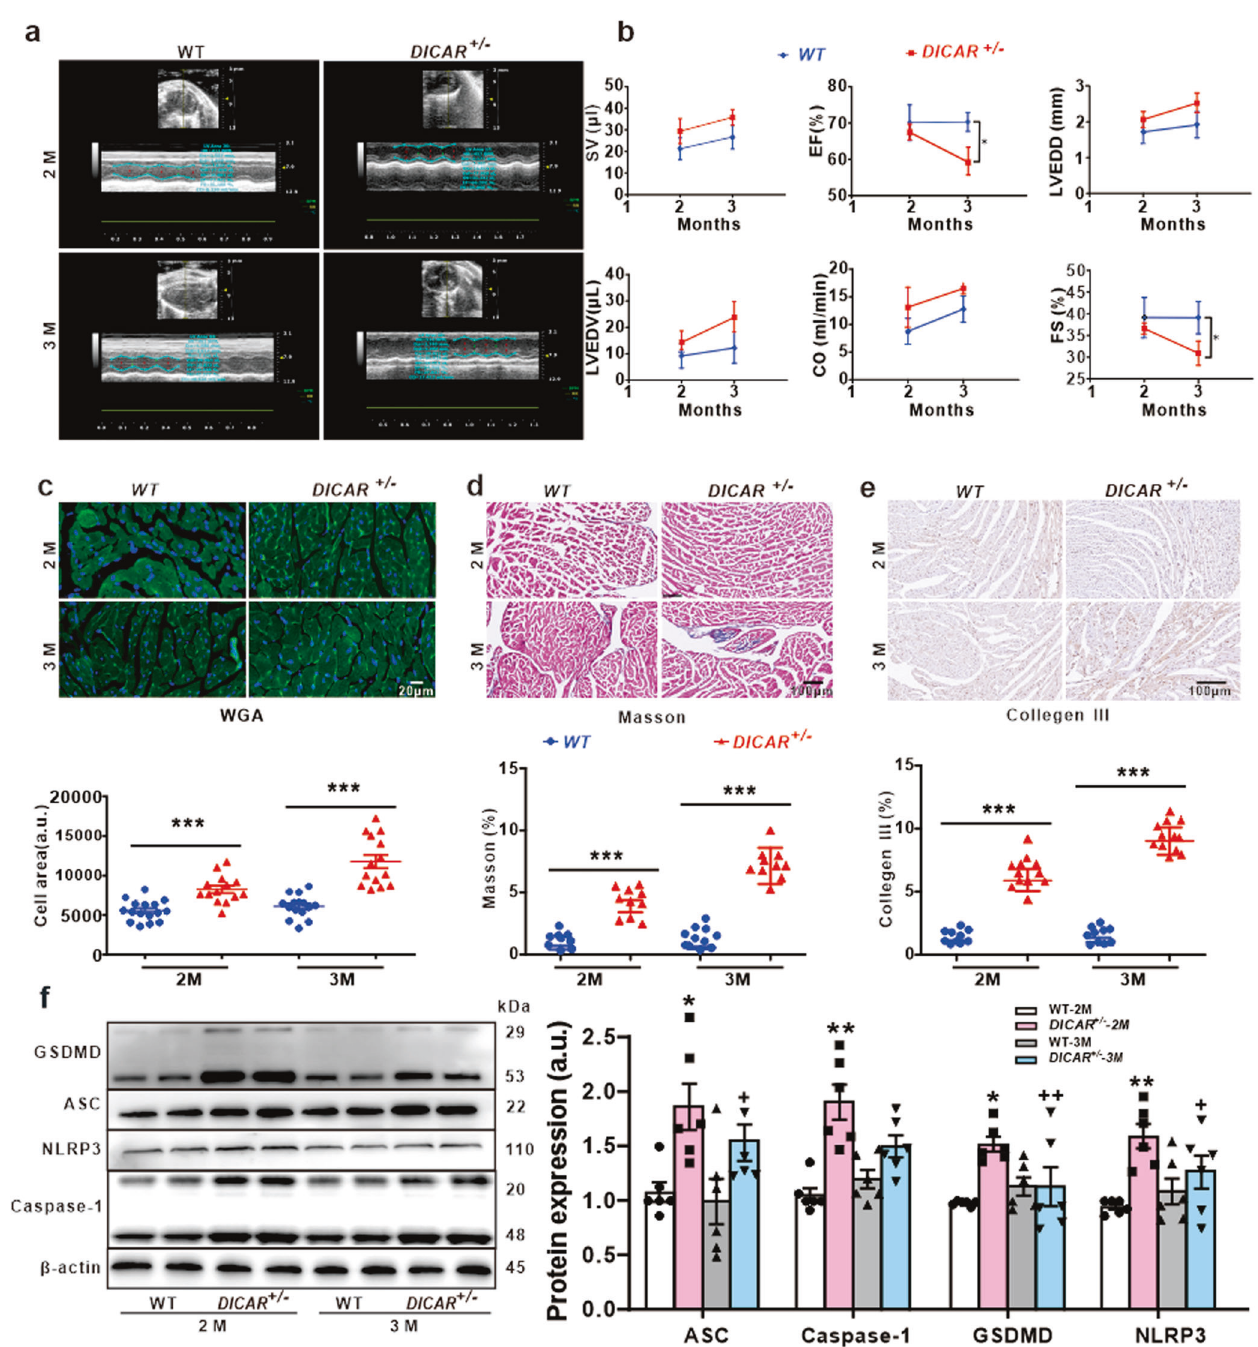
Fig. 2 Effect of DICAR on the cardiac functions and remodeling. a Echocardiography images of DICAR + / − mouse. b Summary of the heart functions, including stroke volume (SV), ejection fraction (EF), left ventricular end-diastolic dimension (LVEDD), cardiac output (CO), fractional shortening (FS). c Representative images and summary data of wheat germ agglutinin (WGA) staining. d Representative images and summary data of Masson staining of DICAR + / − . e Representative IHF images and summary data of collagen III. f Representative and summary data of WB images of pyroptosis detected in the heart tissues. Data are represented as mean ± SEM. * P < 0.05, ** P < 0.01 vs. WT group, n = 6 – 8 Interaction between VCP and DICAR regulates pyroptosis of T2DM (Fig. 3e). We also overexpressed DICAR in cultured cardiomyocytes induced by diabetes mouse cardiomyocytes through the transfection with AD- Bioinformatics ’ analysis of the second structure of DICAR revealed DICAR (adenovirus-expressing DICAR expression) for 48 h a speci fi c stem loop structure in the junction domain (Fig. 1I). As followed by treatment with AGEs (200 µg/mL) for 48 h we found that DICAR located in the cytoplasm of cardiac cells (Fig. in vitro. Western blotting displayed that the effects of AGEs 1g), we determined whether DICAR could interact and regulate on the activation of GSDMD, NLRP3, caspase-1, and ASC were proteins. Chromatin isolation by RNA puri fi cation-mass spectro- inhibited by DICAR overexpression in these mouse cardiomyo- metry (ChIRP-MS), a method used to detect the binding proteins cytes (Fig. 3f). Signal Transduction and Targeted Therapy (2023)